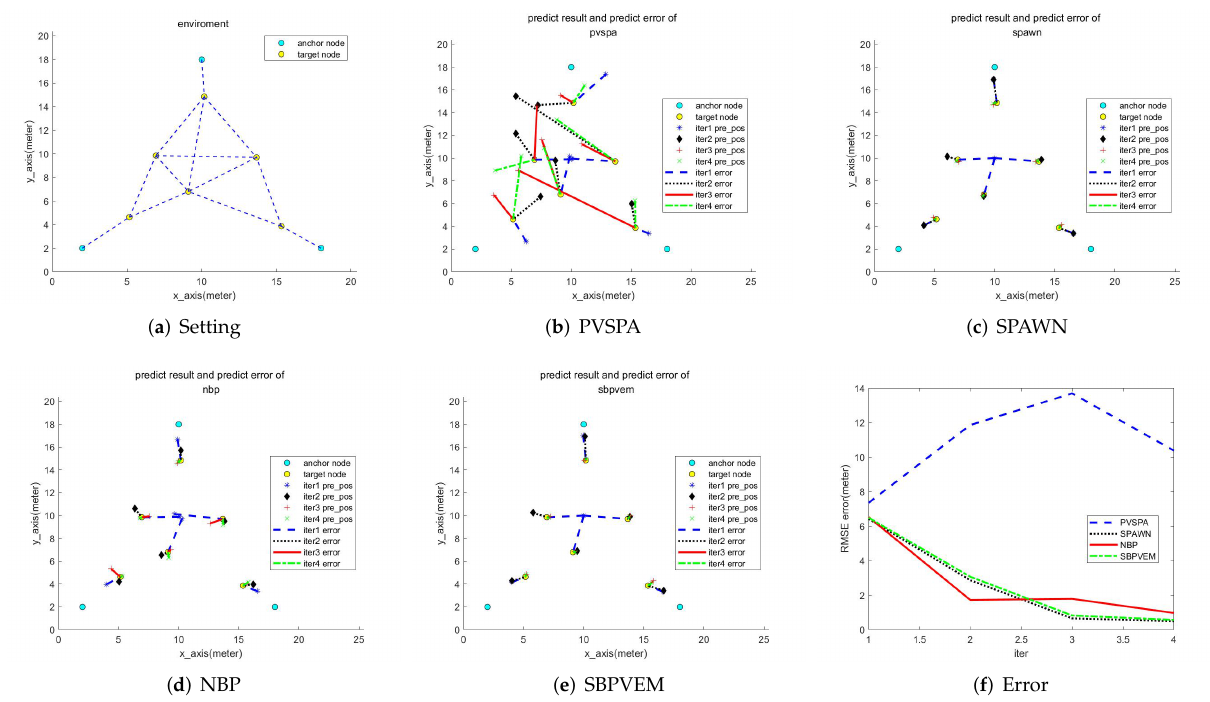
Figure 6. Location results of connection scenario 3. ( a ) exhibits the setting of scenario 2. Anchors are represented by cyan nodes, whereas yellow nodes represent targets. Blue dotted lines link two nodes with communication. PVSPA, SPAWN, NBP, and SBPVEM iterative positioning results and corresponding positioning errors are shown in ( b – e ). ( f ) comparing the prediction errors of various algorithms in the iterative